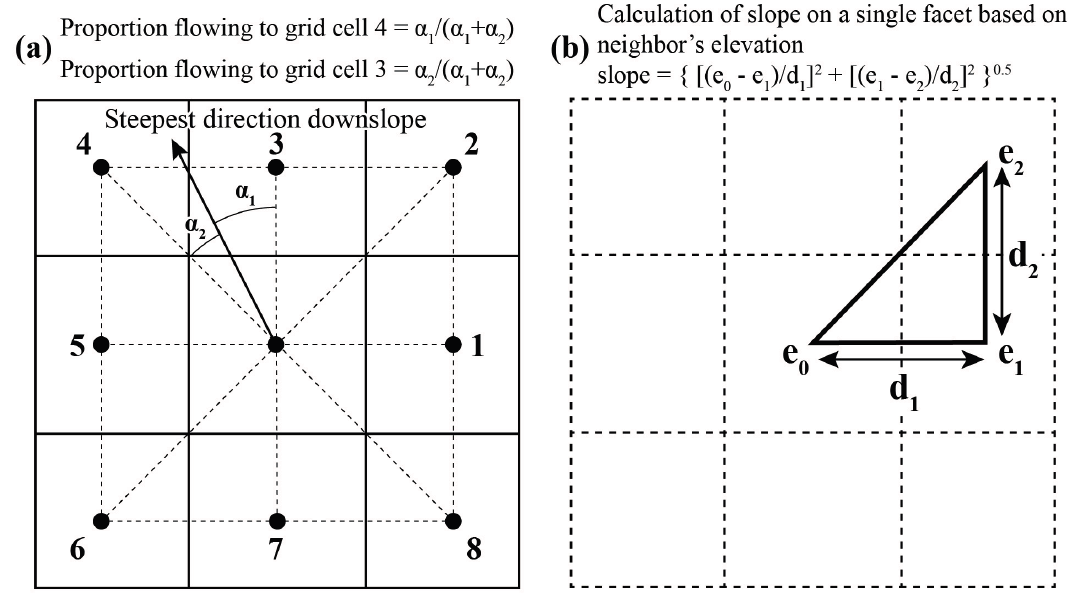
Figure 3. Flow direction using the D-infinity flow model (redrawn from [21]): ( a ) shows proportion of water flowing into two adjacent cells; and ( b ) shows calculation of slope on a single